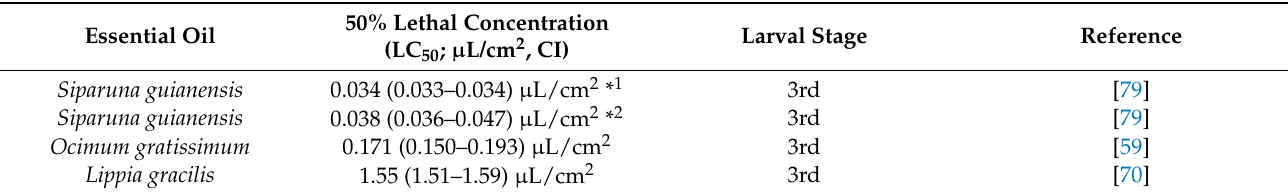
Table 6. Lethal effects obtained by contact toxicity